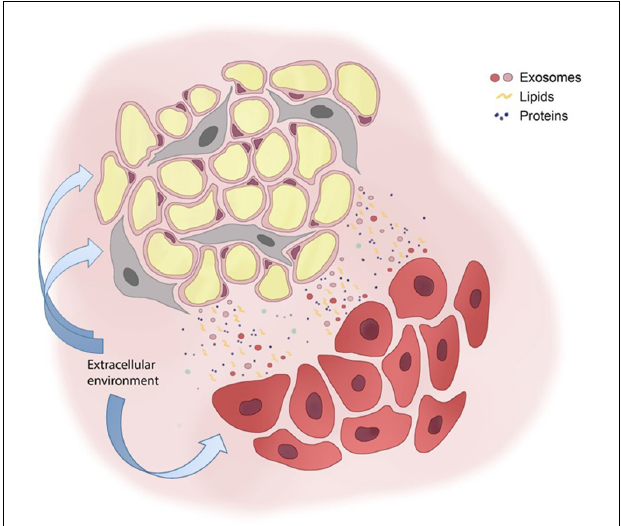
FIGURE 1 | Adipose and breast cancer cell bidirectional communication. Adipocytes (yellow round cells) and mesenchymal stem cells (gray elongated cells) communicate with breast cancer cells (red cells) with a plethora of signals that include exosomes, lipids and proteins. The extracellular environment affects either adipose cells either cancer cells, thus interfering on cell-cell communication systems.